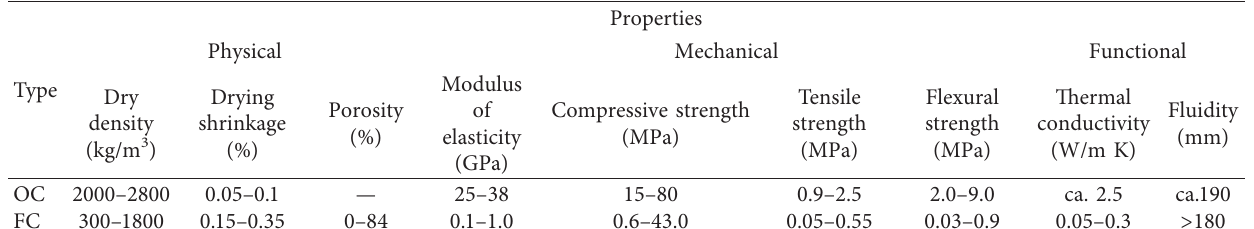
Table 6: Tabulation presents properties comparison between OC and FC [36, 107, 131, 167,